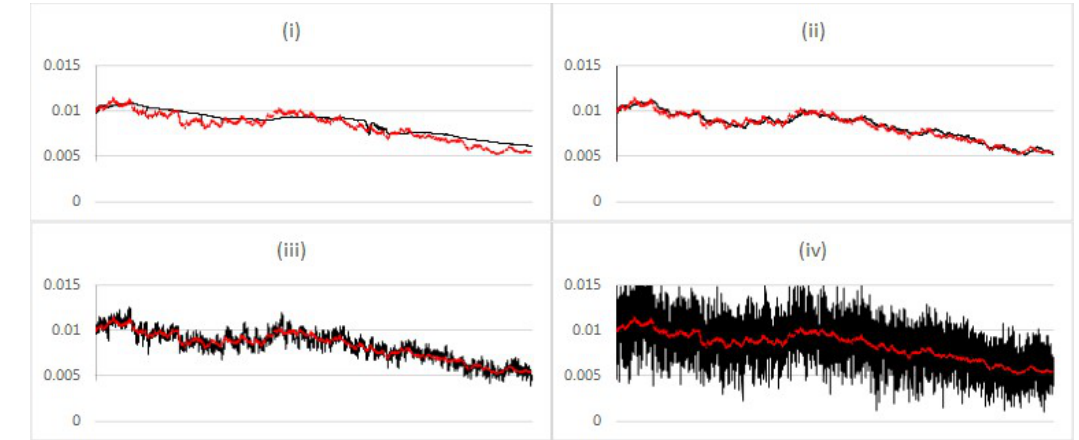
Figure 3. Comparing estimated posterior expected value (black) vs. simulation input value (red) of α in the stochastic volatility model, using the Liu and West filter with additional noise, for different values of φ ( i ) 0.1 ( iv ) 100.0 N